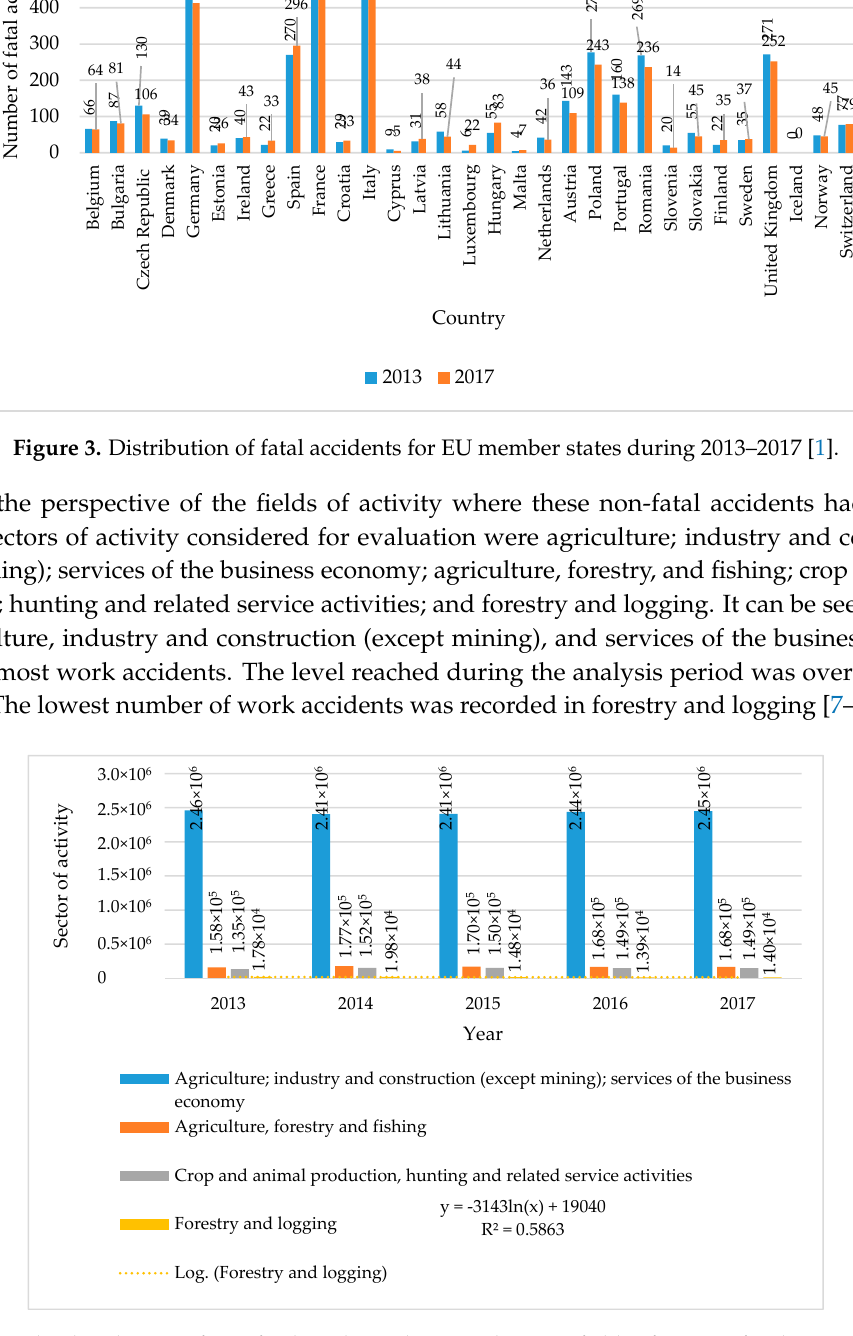
Figure 2. Situation of fatal accidents at the level of the European Union during 2013–2017 [2].